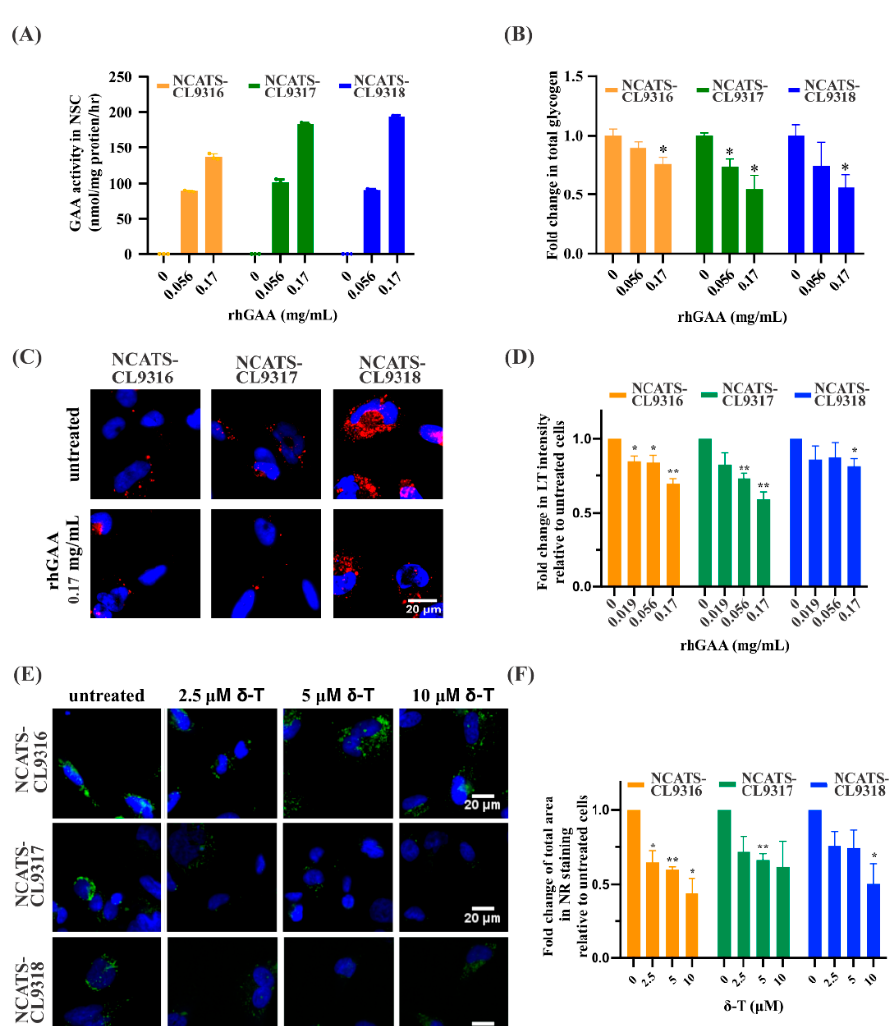
Figure 3. Phenotypic effects of rhGAA and δ -tocopherol in Pompe disease NSCs. ( A ) Bar graph presents GAA activities in rhGAA treated NSCs. ( B ) Bar graph presents fold change of total amount of cellular glycogen in disease NSCs with rhGAA treatment. (* p < 0.05 by t -test; errors bars are derived from the SEM of three independent experiments). ( C ) Representative images of LysoTracker staining (red) in rhGAA treated NSCs. ( D ) Bar graph presents the quantitation of LysoTracker (LT) staining after rhGAA treatment; blue (Hoechst) staining indicates nuclei (* p < 0.05 and ** p < 0.01 by t -test; errors bars are derived from the SEM of three independent experiments). ( E ) Representative images of Nile red staining (green) of δ -tocopherol ( δ -T) treated NSCs. ( F ) Bar graph presents the quantitation of Nile red (NR) staining after δ -tocopherol treatment. Error bars represent SEM of three independent experiments (* p < 0.05 and ** p < 0.01 by t -test).